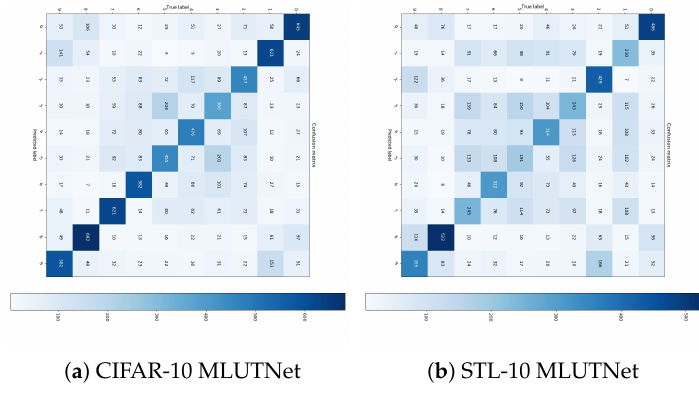
Figure 8. Performance on CIFAR-10 and STL-10